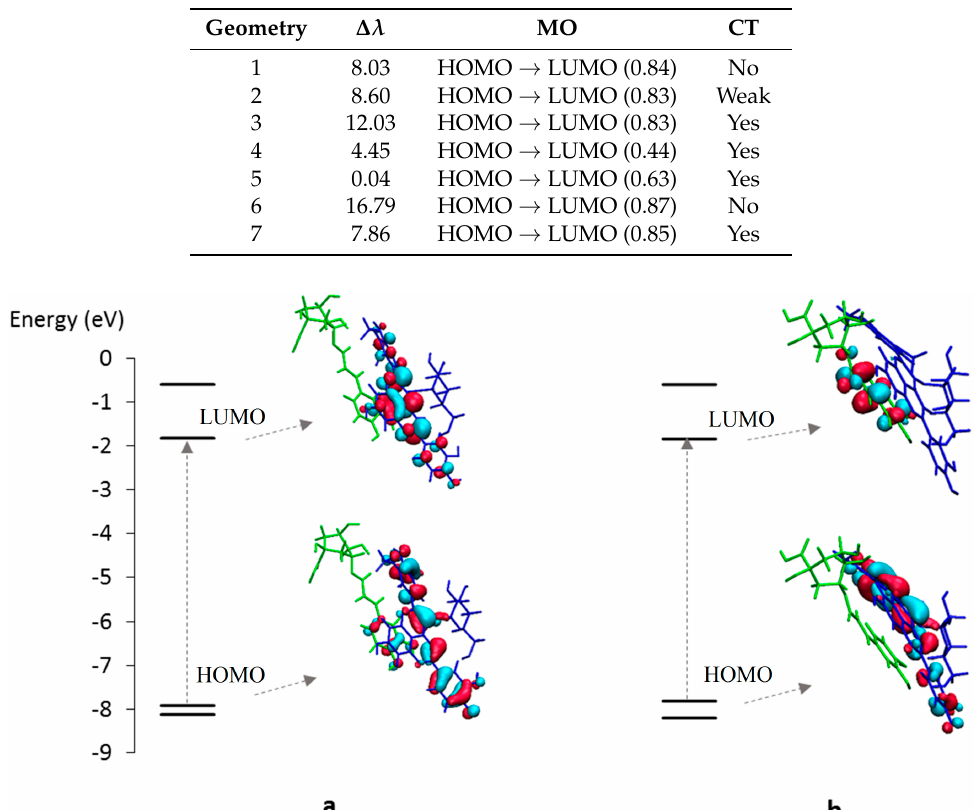
Figure 13. Molecular orbital description of the copigmentation complex of PA1 (flavylium ion) with chlorogenic acid: without ( a ); or with ( b ) CT character in the excited state.